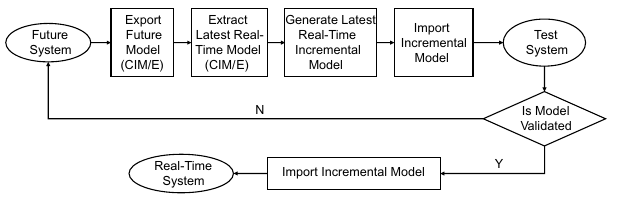
Fig. 4 Process of generating model data.